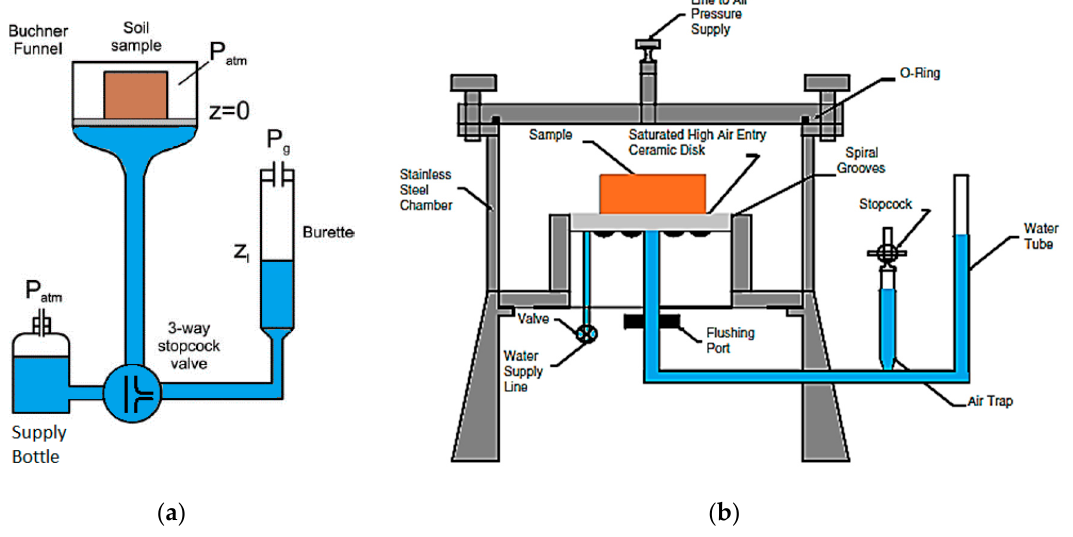
Figure 4. Standard Axis Translation Techniques: ( a ) a sketch of the hanging column method; ( b ) a sketch of the pressure chamber method [110].